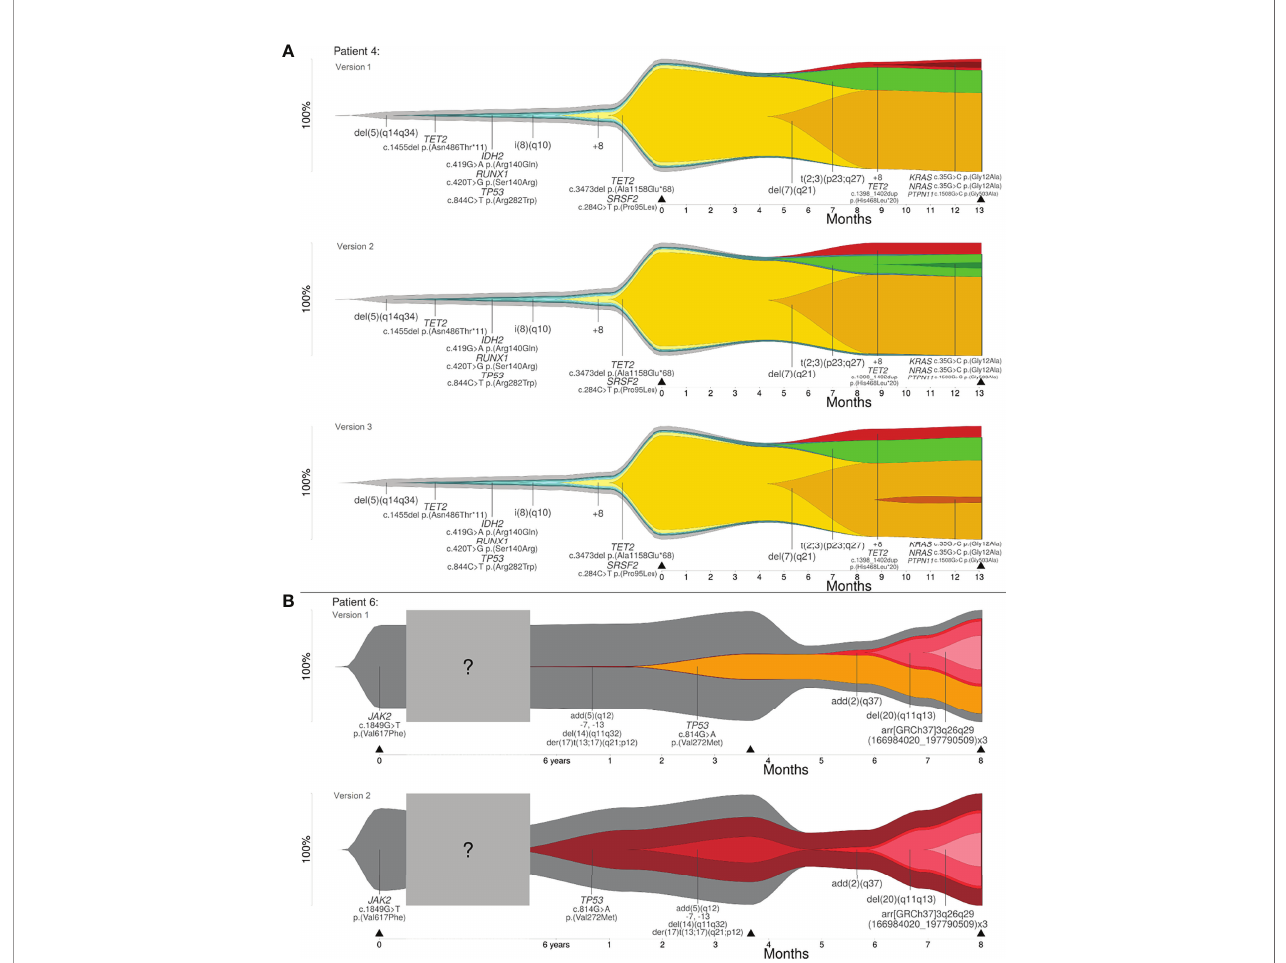
FIGURE 3 | (A) Clonal evolution patterns of patient 4: three versions of branched evolution. (B) Clonal evolution patterns of patient 6: linear and branched evolution. Y-axis represents the percentage of clone size and black triangles indicate the analyzed time